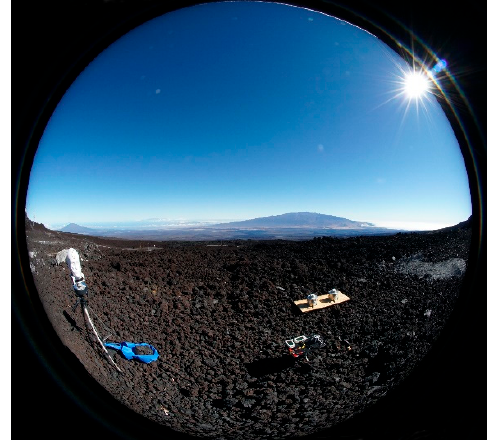
Figure 8. Horizontal 190° view of the sky and surface that approximates the field of view (FOV) of the mannequin head-mounted UVR sensors. This image was made at 8:52 on 11 July 2018 at MLO. The mannequin head is on the left, and the PMA1102 is to its right. Mauna Kea is in the background.